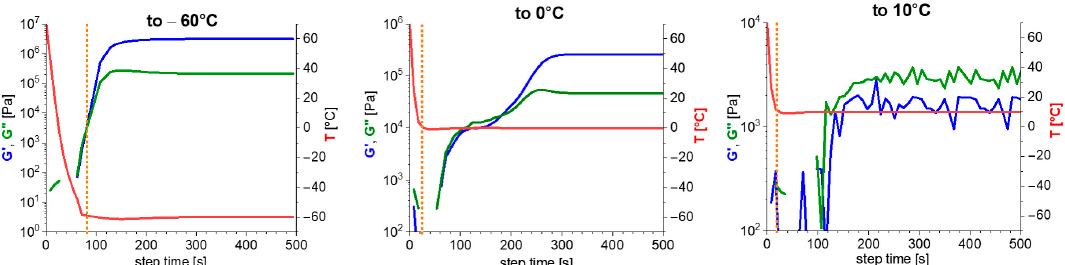
Figure 4. Exemplary kinetics of the change in storage ( G (cid:48) ) and loss ( G ”) modulus (kinetics of physical gelation) upon quenching molten H21–BAFKU 2 from 70 ◦ C down to temperatures between − 60 ◦ C and + 10 ◦ C; the complete set of results for all the di ff erent final temperatures tested is shown in Figure S4; at final temperatures above + 45 ◦ C, practically no change in moduli is observed upon quenching the